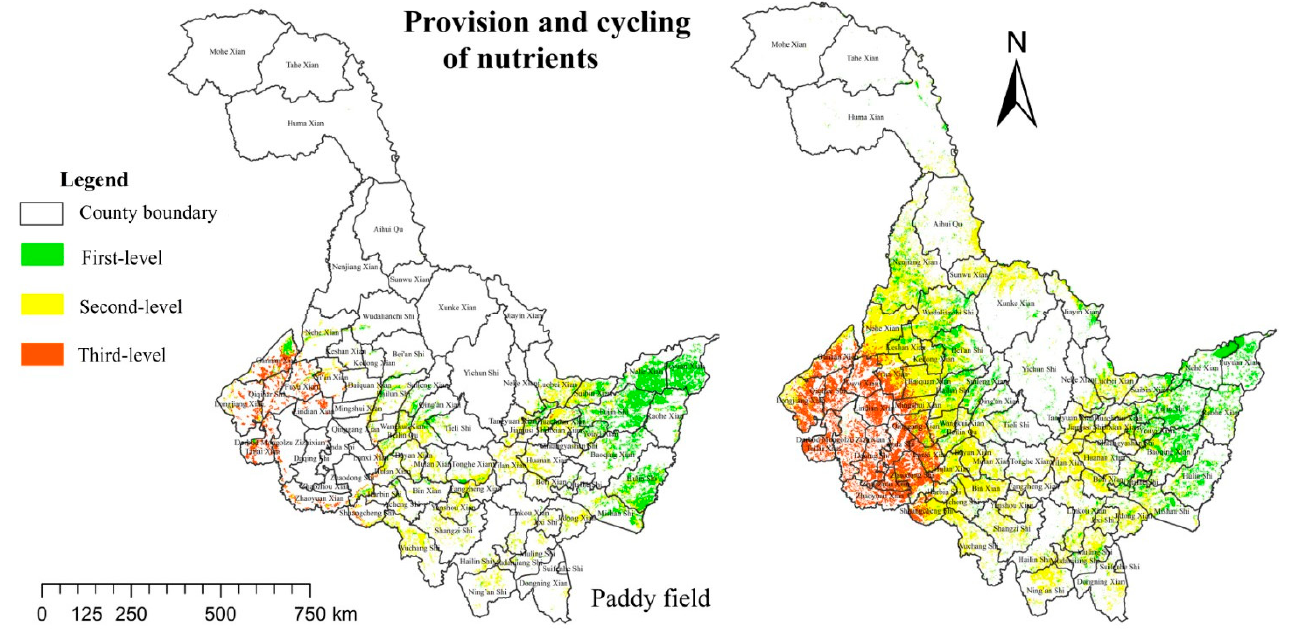
Figure 6. The grade of provision and cycling of nutrients function in paddy fields and